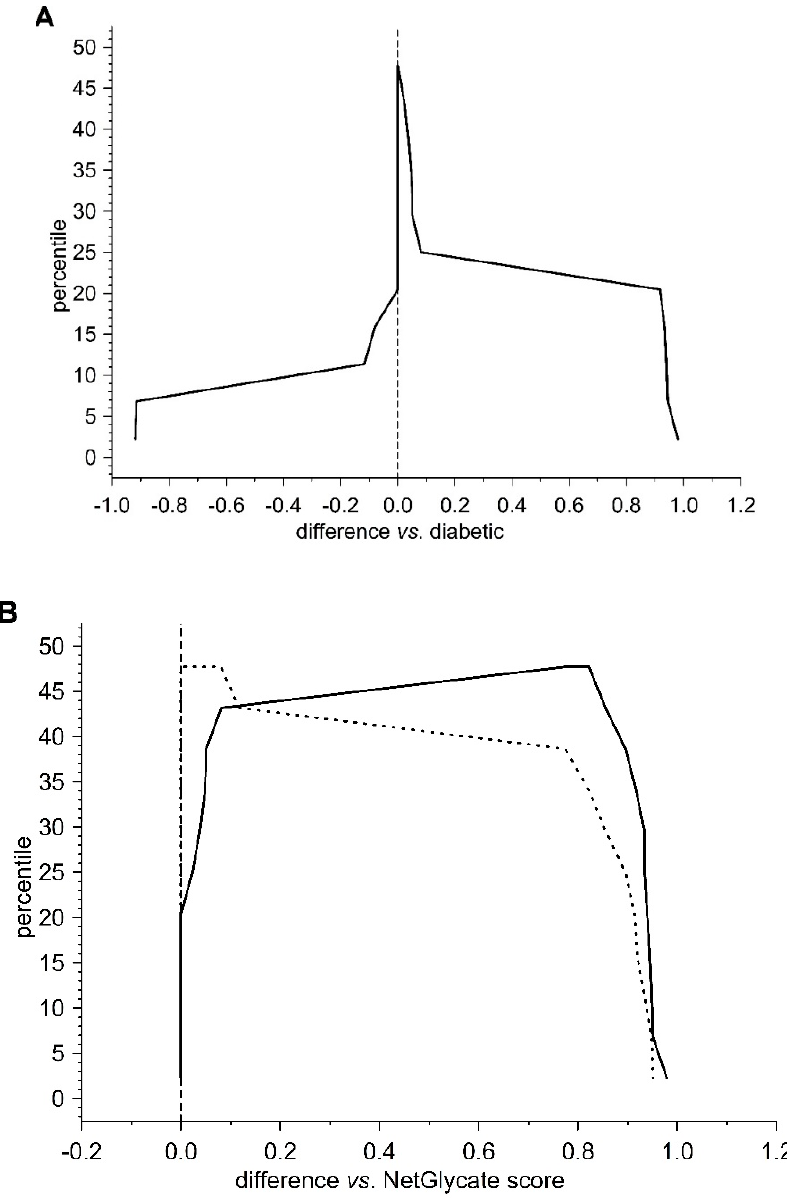
Figure 4. Mountain plots comparing the NetGlycate scores of glycation sites in control subjects and T2DM patients with theoretical estimates for glycation positions of high or low glycation potential in alpha chain of fibrinogen. The plot was created by evaluating the percentiles for ascending differences between the normalized scores: ( A ) differences of the NetGlycate-estimated scores (normalized to the scale from 0 to 1) between diabetic patients and control subjects ( norm score diabetic − norm score control ), ( B ) differences of the NetGlycate-estimated scores (normalized to the scale from 0 to 1) between theoretical estimates for high or low glycation potential sites and the actual glycation sites revealed in diabetic patients (solid line) and control subjects (dashed line) ( norm score theoretical – norm score control ; norm score theoretical – norm score diabetic ).